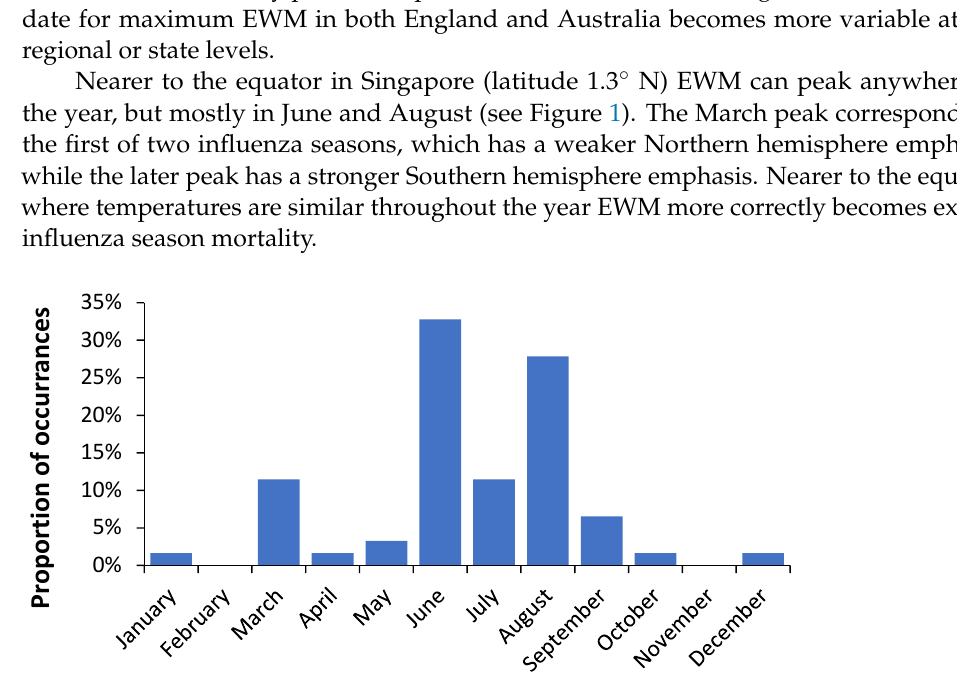
Figure 1. Month at which a rolling EWM (Excess Winter Mortality) calculation reaches a maximum in Singapore, 1960 to 2020.